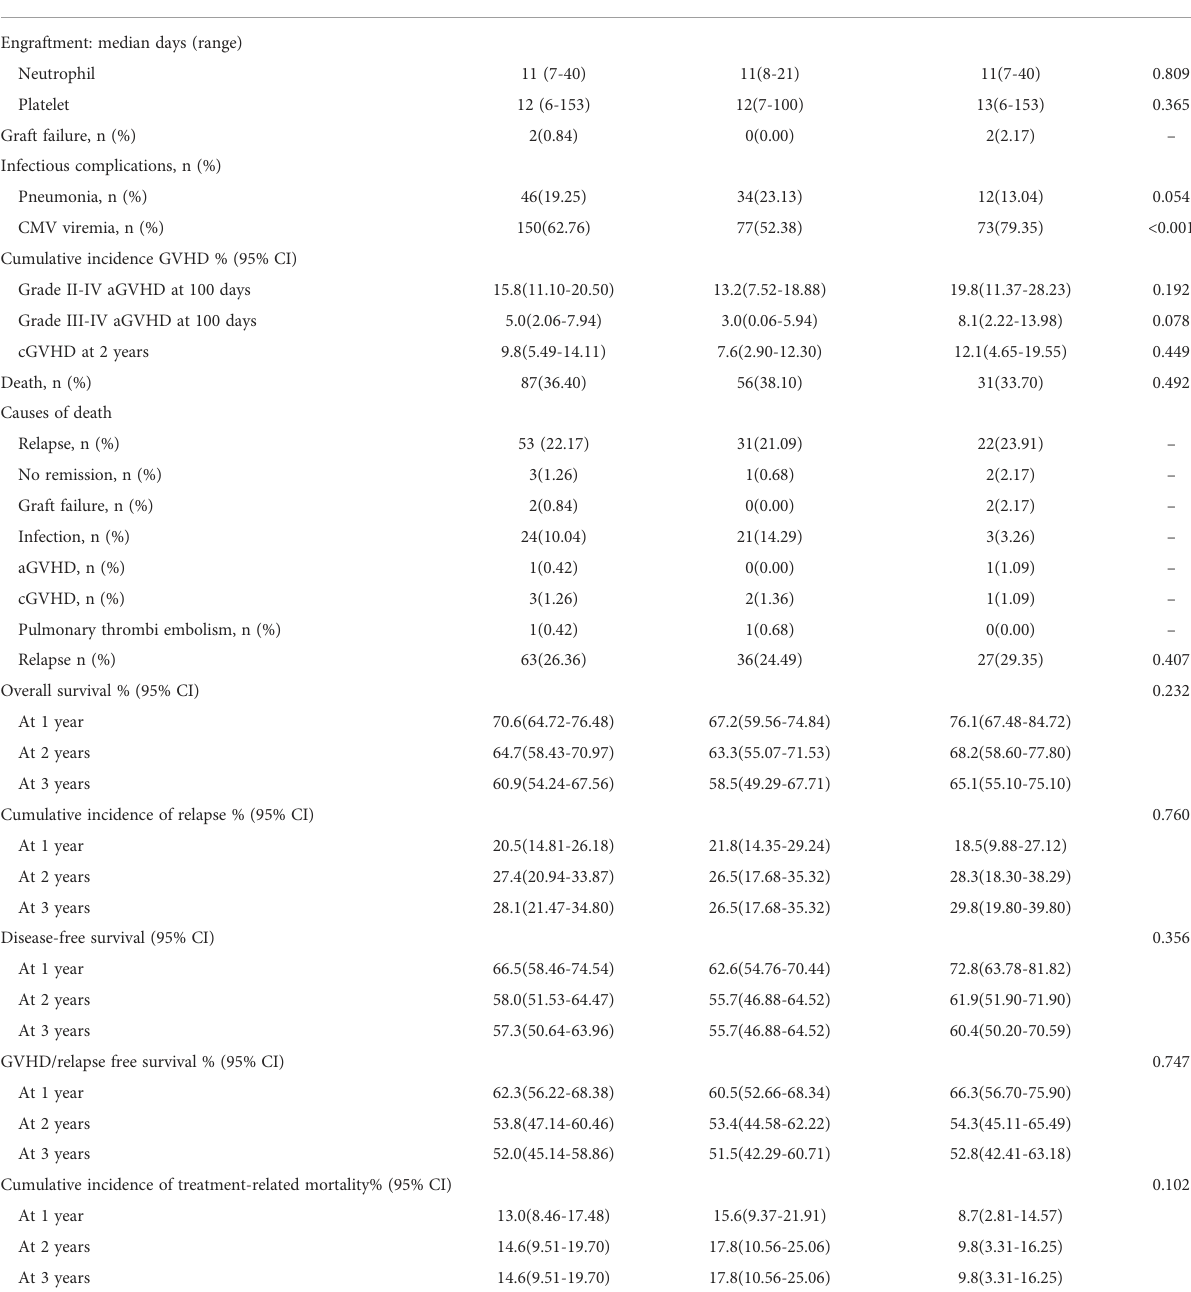
TABLE 2 Post-transplant information and outcomes. Post-transplant information and